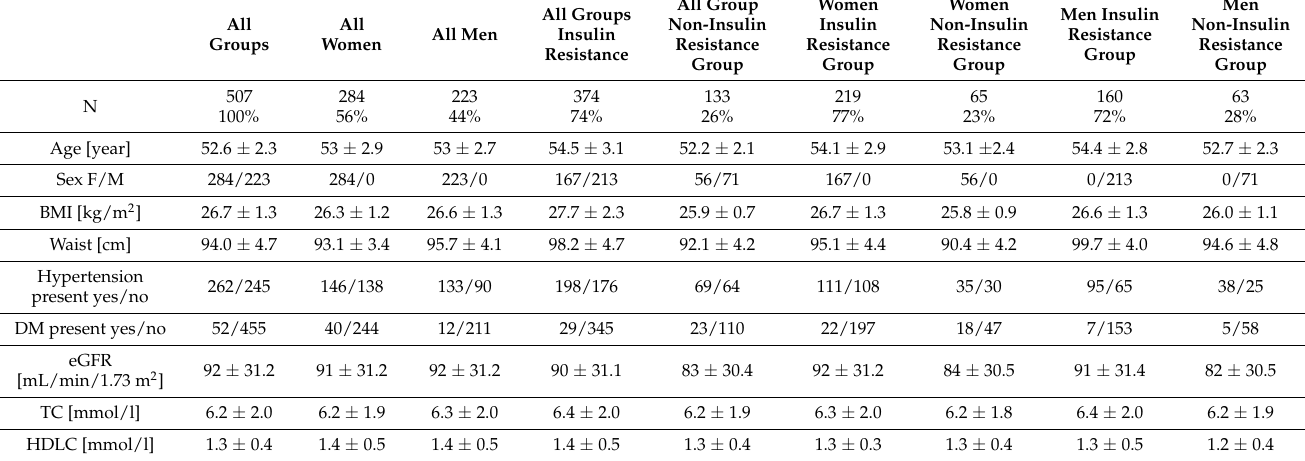
Table 1. Basic information about the